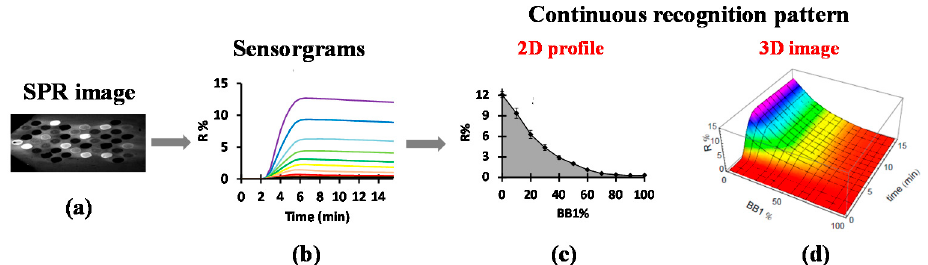
Figure 2. Data treatment for the generation of continuous recognition patterns. ( a ) SPR image recorded by a CCD camera; ( b ) Sensorgrams for all the spots; ( c ) a 2D continuous evolution profile (CEP) and ( d ) a 3D continuous evolution landscape (CEL), also called a 3D image, generated by the electronic tongue (eT). Reprinted from [30] with permission from JoVE.